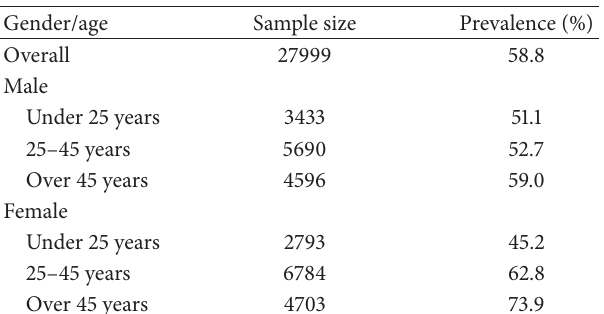
Table 1: Demographics of the study population and prevalence of dry eye in each gender/age group.